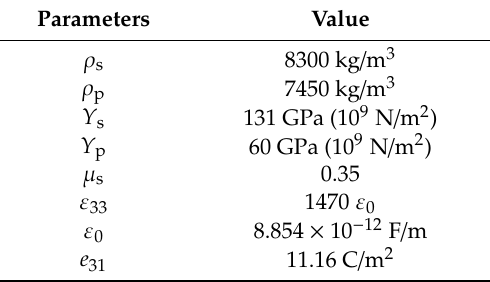
Table 1. Material parameters.